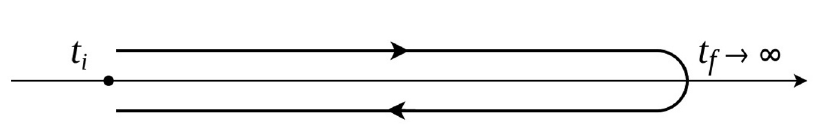
Figure 1 . The Keldysh contour C for the generating functional in the CTP